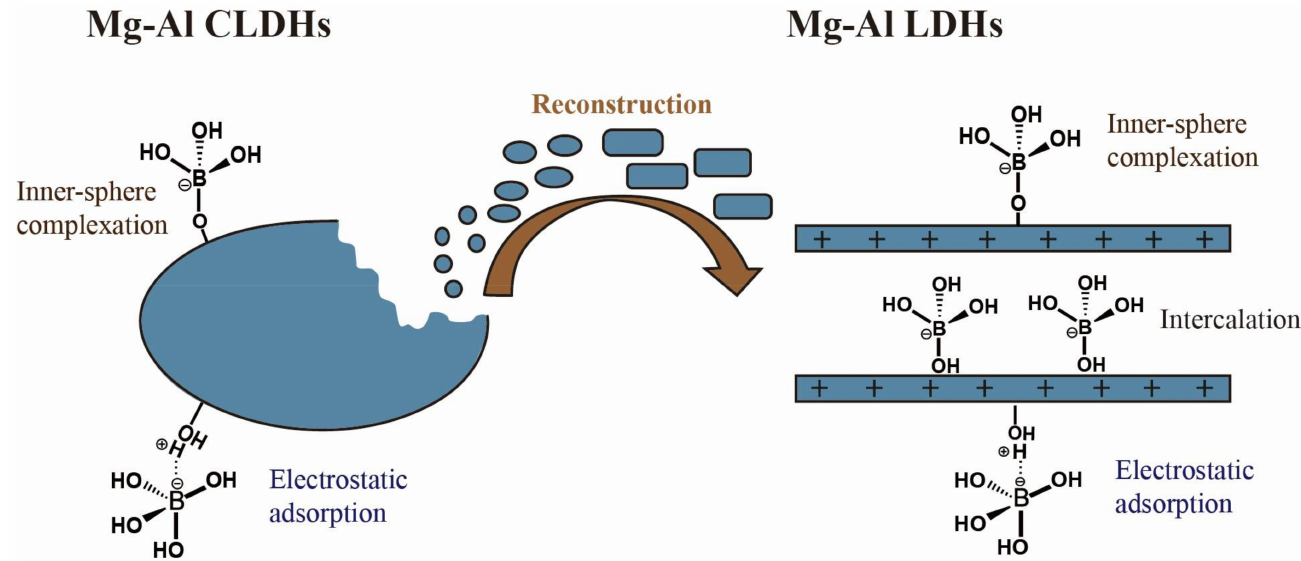
Figure 8. Mechanism of boron adsorption on Mg-Al layer-double hydroxides (LDHs). Reproduced based on